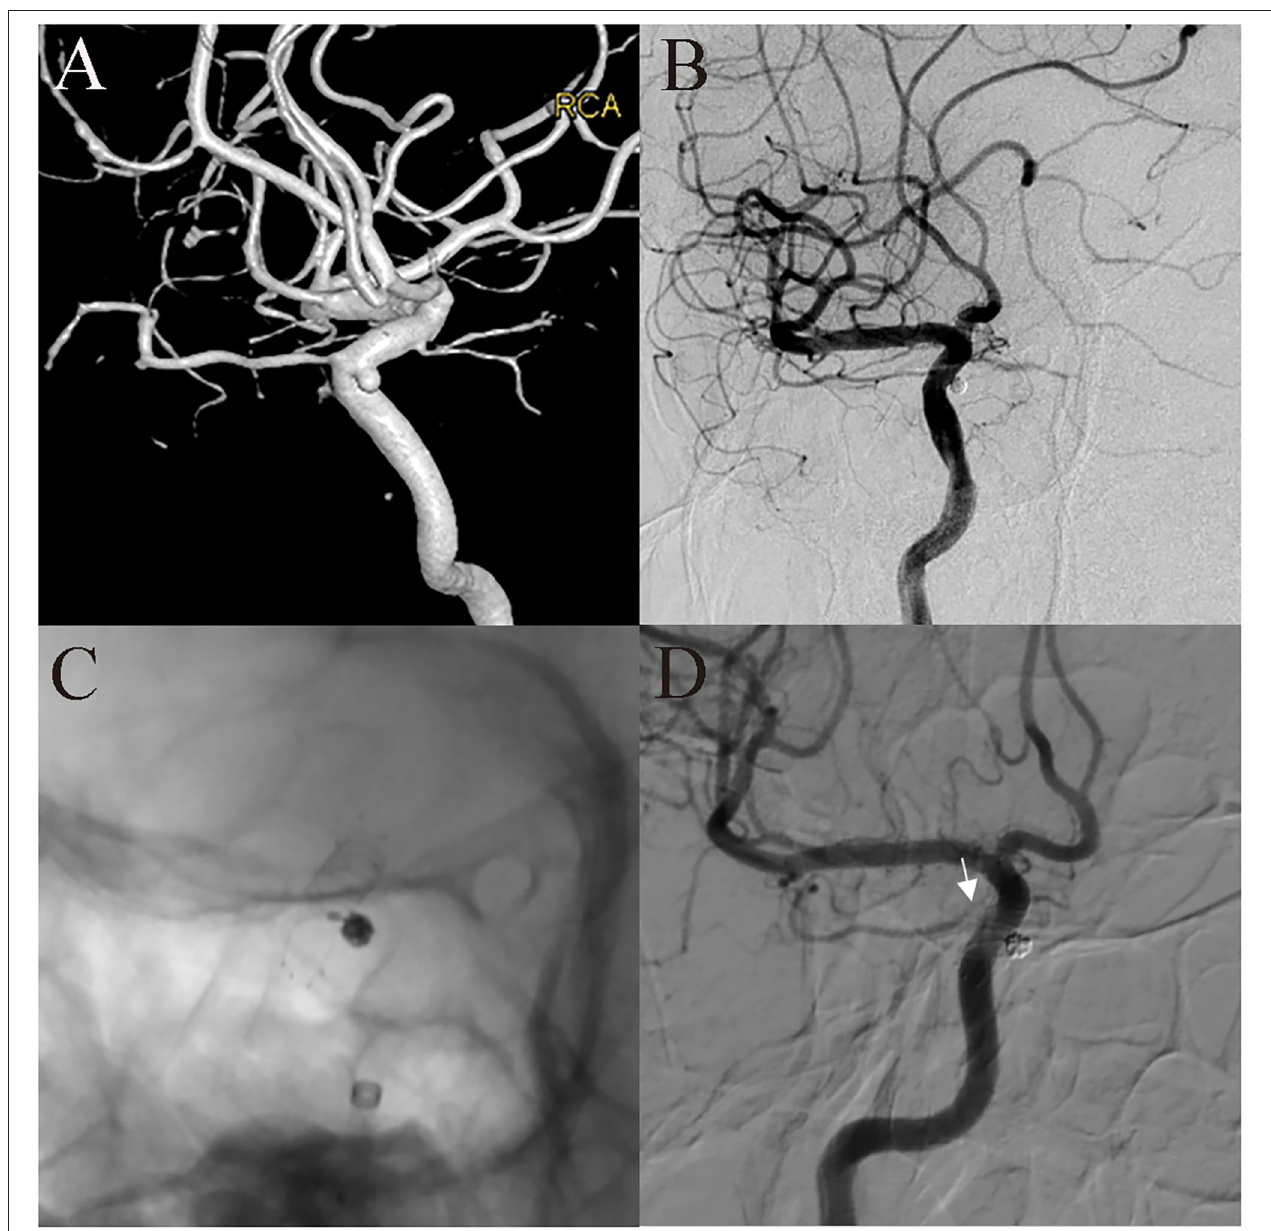
FIGURE 4 | A 52-year-old female patient with intermittent dizziness for 1 year was found to have a tiny aneurysm. DSA showed a small aneurysm in the ophthalmic segment of the ICA (A) , and LVIS-assisted coil embolization was performed using the compressed stent technique. Immediately after embolization, the aneurysm was completely embolized (B) , and the ophthalmic artery was patent. The LVIS stent was compressed at the aneurysm neck (C) . The 14-month follow-up images showed no recurrence of the aneurysm, but the initial segment of the ophthalmic artery was narrowed ( D , white